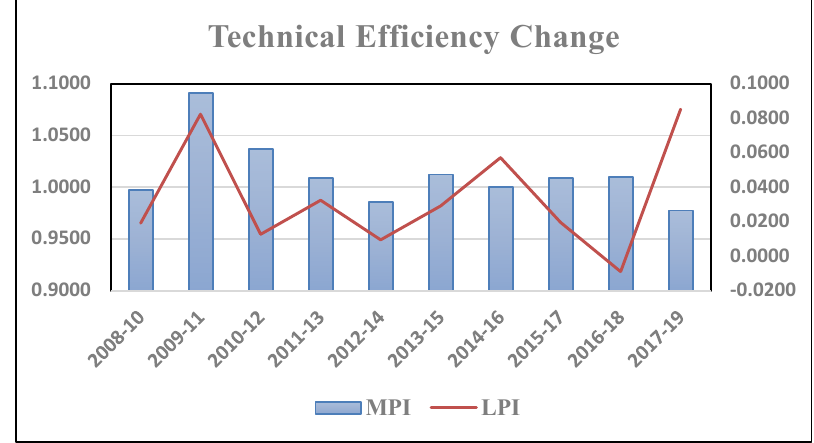
Fig. 2 . Malmquist and Luenberger Technical Efficiency Change in 2008-19